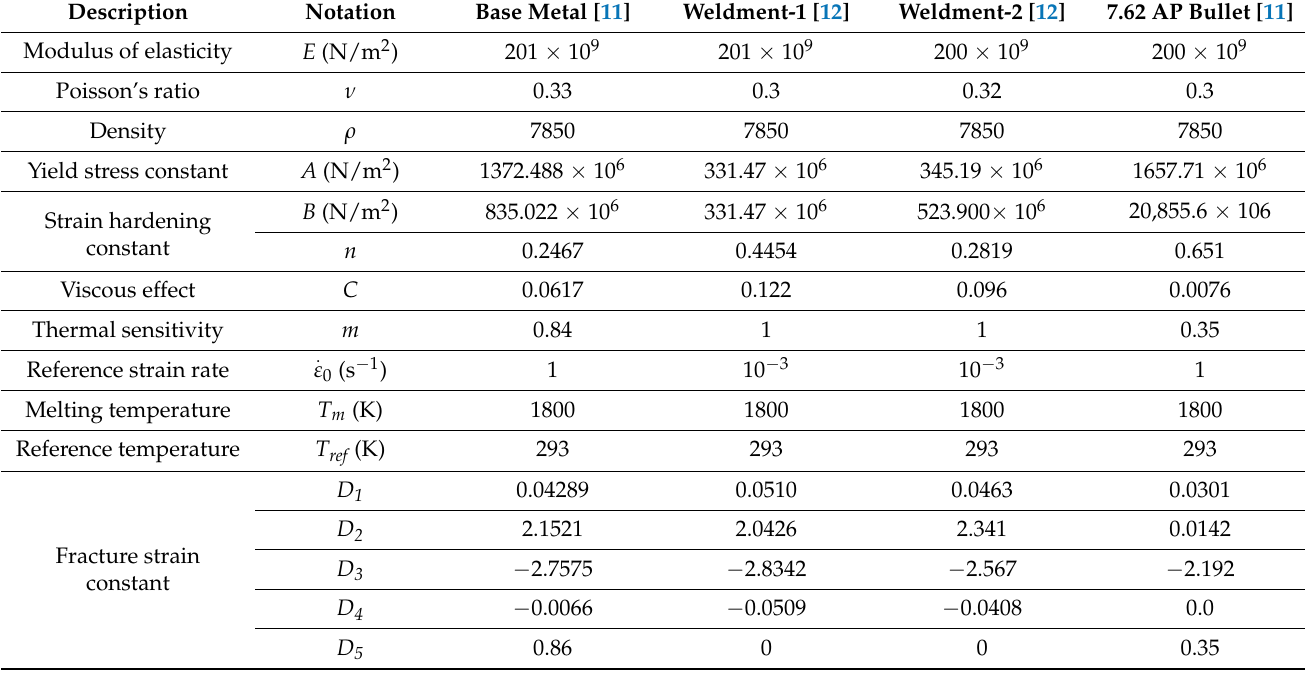
Table 2. Material parameters of investigated materials used in Numerical